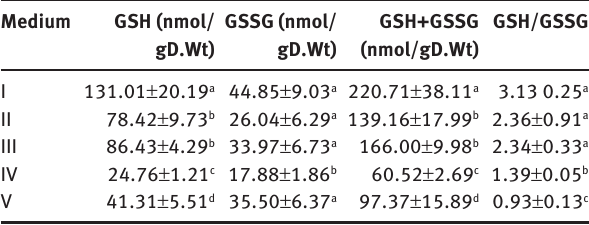
Table 1: GSH, GSSG, GSH+GSSG (calculated as [GSH]+2[GSSG]) contents and GSH/GSSG ratio of S.cerevisiae UE-ME medium, II-YEPGD medium, III-YEPGD medium and 5 μ g/ml TiO NP add at 100 min, IV-YEPGD medium with heat-shock (28/40 ° C) at 100 min,V-YEPGD medium and 5 μ g/ml TiO (28/40 ° C) at 100 min.